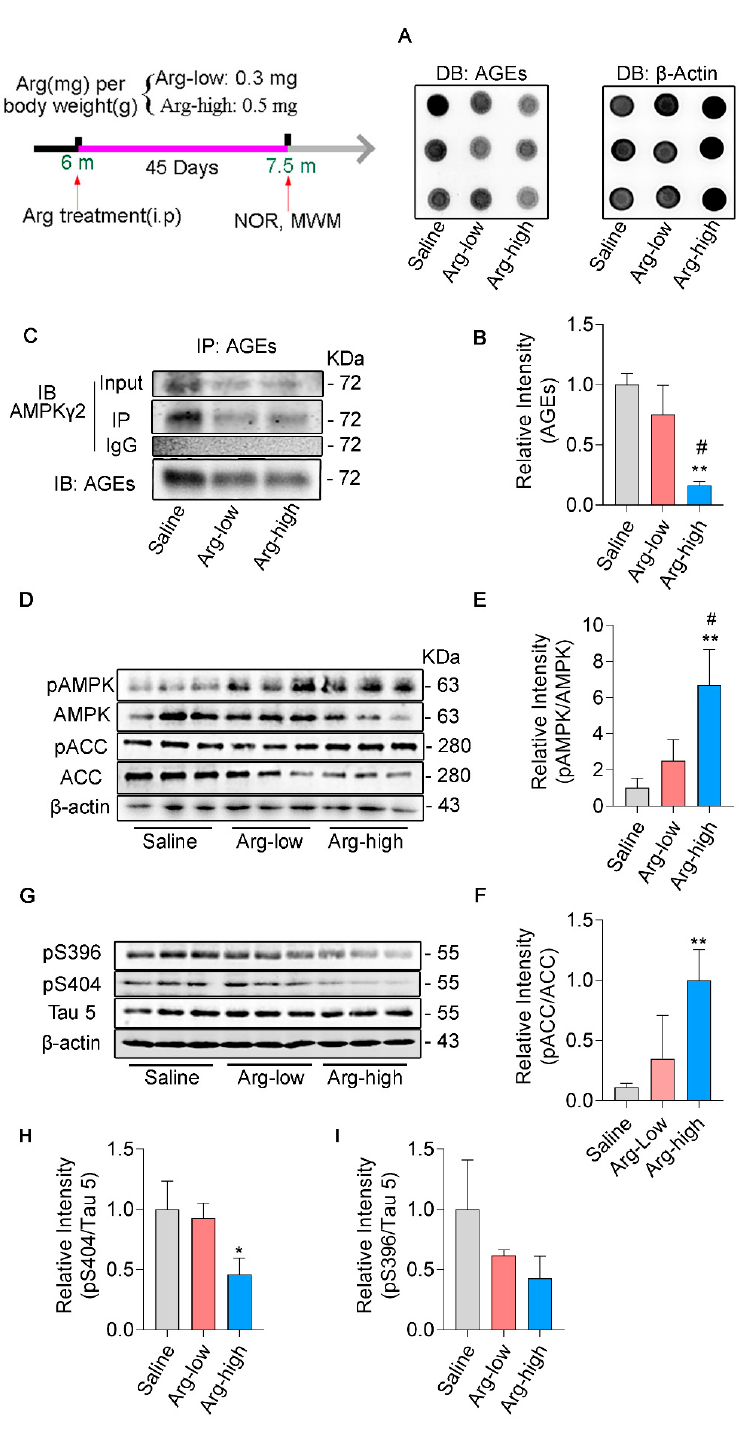
Figure 4. Arginine defends γ 2 subunit of AMPK against its glycation and improves AMPK function in 3 × Tg mice. The hippocampi were extracted from 3 × Tg Saline group (Saline), 3 × Tg Arg − low group (Arg − low), 3 × Tg Arg − high group (Arg − high) at 7.5 − month − old. ( A , B ) The levels of hippocampal AGEs were examined by dot blot with antibody against anti − AGEs. ( C ) Dissected hippocampi were immune − precipitated with antibody against AGEs and then examined by western blot with antibody against AMPK γ 2 . ( D – I ) The expressions of AMPK, pT172 − AMPK, pS79 − ACC, ACC, Tau 5, pS396, and pS404 were examined by western blot. All data were exhibited as the means ± SD ( n = 3), statistical analysis with one − way ANOVA with a post hoc Turkey’s test. * p < 0.05, ** p < 0.01 vs. Saline group, # p < 0.05 vs. Arg − low